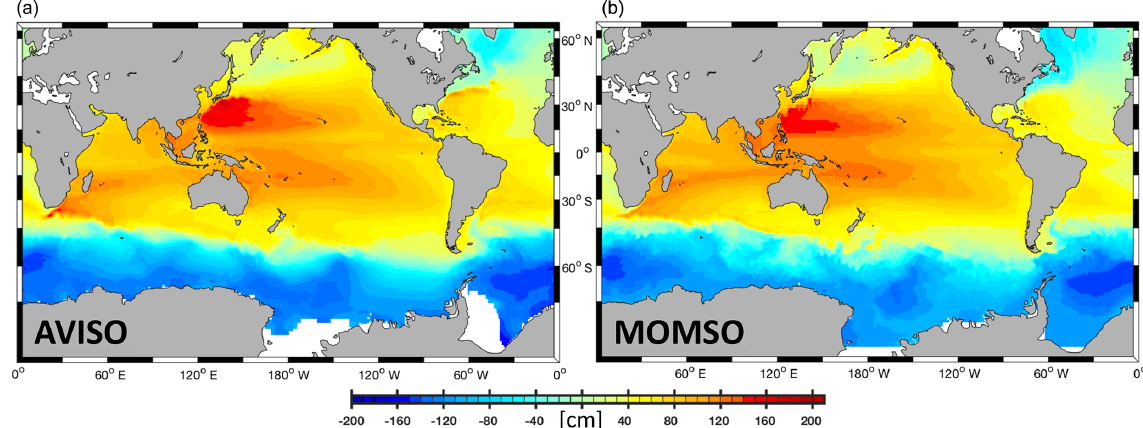
Figure 4. Climatological mean sea surface height in units of centimeters. Panel (a) shows a 1993 to 1998 climatological average observed from space (Maps of Absolute Geostrophic Current (MADT) Aviso data). Panel (b) shows a 6-year average (nominal years 1993 to 1998) simulated with the reference simulation. The white patches in panels (a) and (b) indicate missing data and (spurious) model land mask,